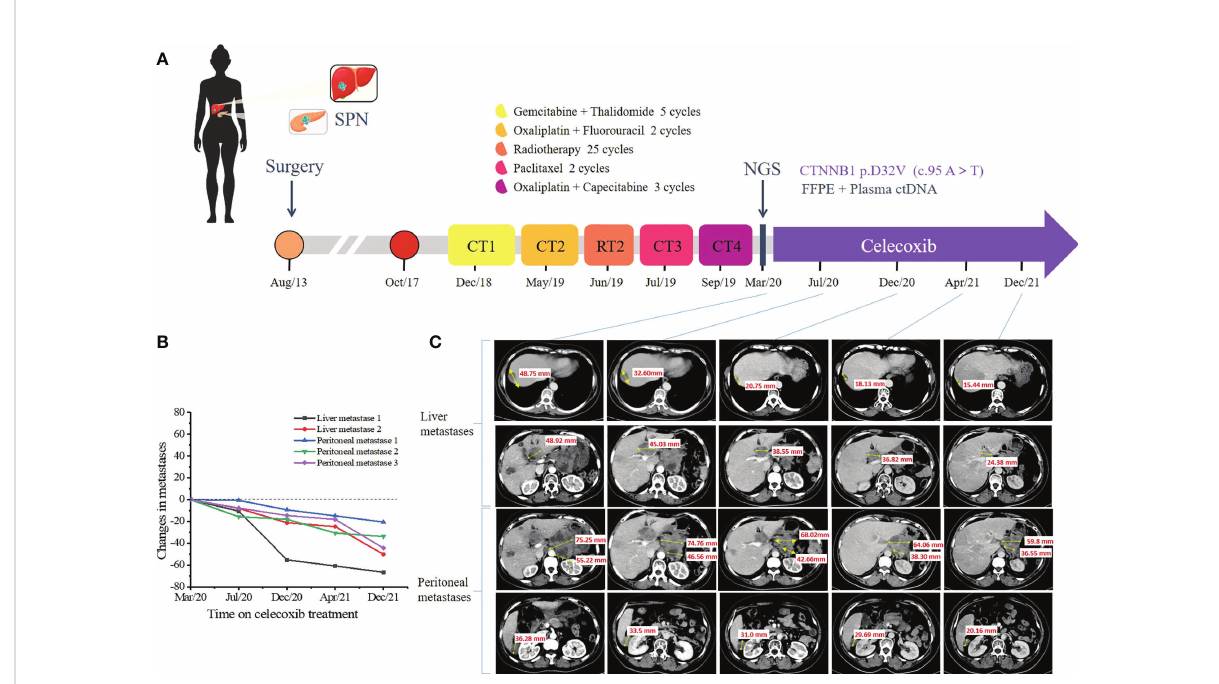
FIGURE 2 Representative clinical images during the treatment course. (A) Disease time line showed the various treatment received by the patient. (B) Scatter plot illustrates changes in liver metastases and peritoneal metastases. Computed tomography (CT) scan data at the fi rst time to use celecoxib is chosen as time 0. (C) Computed tomography scan showed the multiple metastatic lesions in the liver and abdominal cavity under the celecoxib monotherapy. Tumor lesions were pointed with yellow arrows. (SPN, solid pseudopapillary neoplasm; CT, chemotherapy; RT, radiotherapy; NGC, next-generation